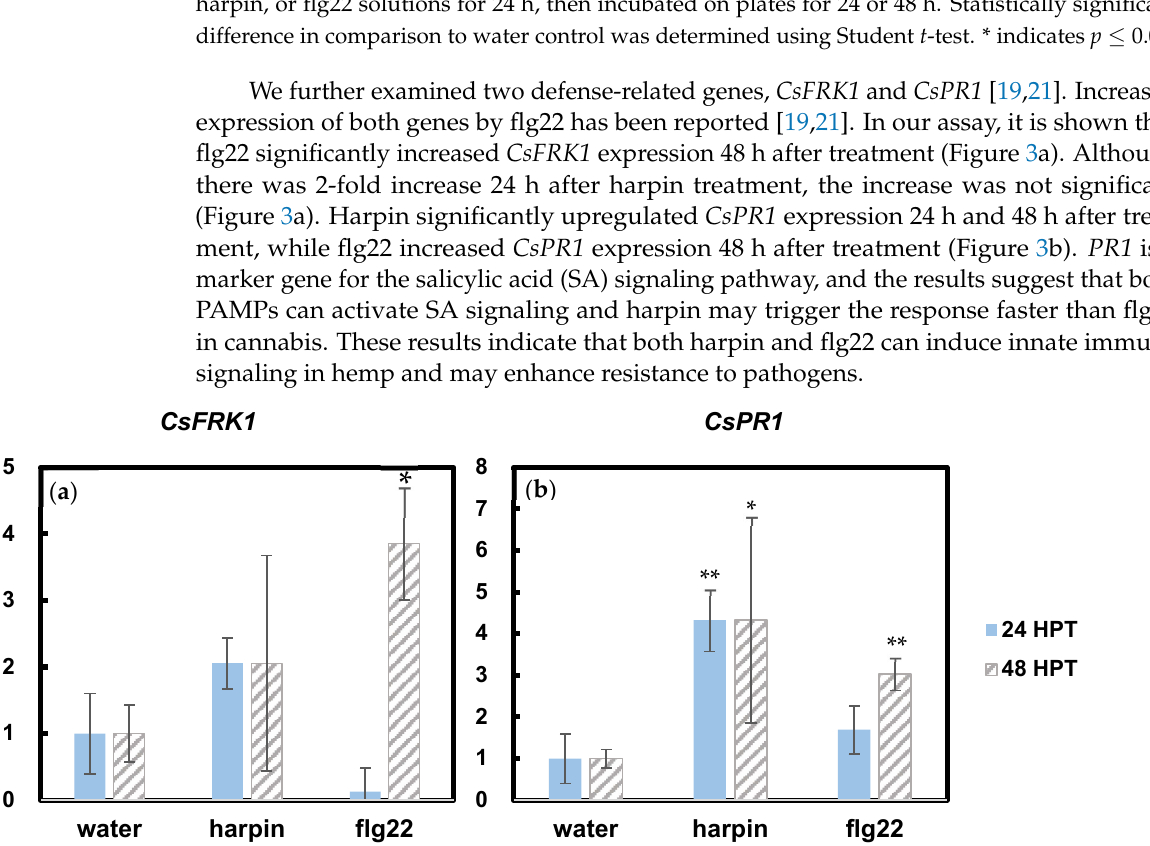
Figure 3. Effects of harpin and flg22 on the expression of defense marker genes, CsFRK1 ( a ) and CsPR1 ( b ), in cannabis seedlings. The RNA samples were the same as those shown in Figure 2. Statistically significant difference in comparison to water control was determined using Student t -test. * indicates p ≤ 0.05. ** indicates p ≤ 0.01.